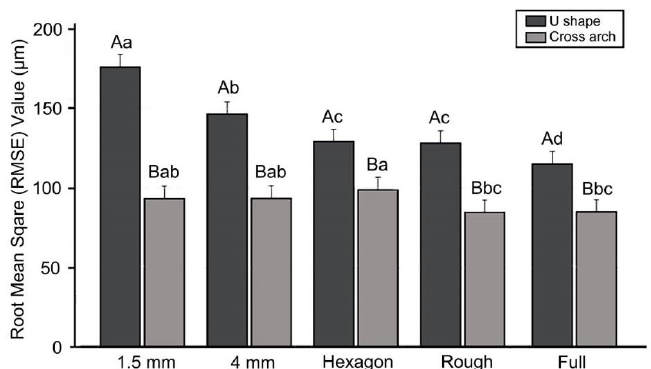
Figure 5. Results of the trueness analysis between Groups P and U. Lowercase letters indicate significant di ff erences between internal structures within the Groups U or P each, and uppercase letters indicate significant differences between Groups P and U within the same internal-structure.